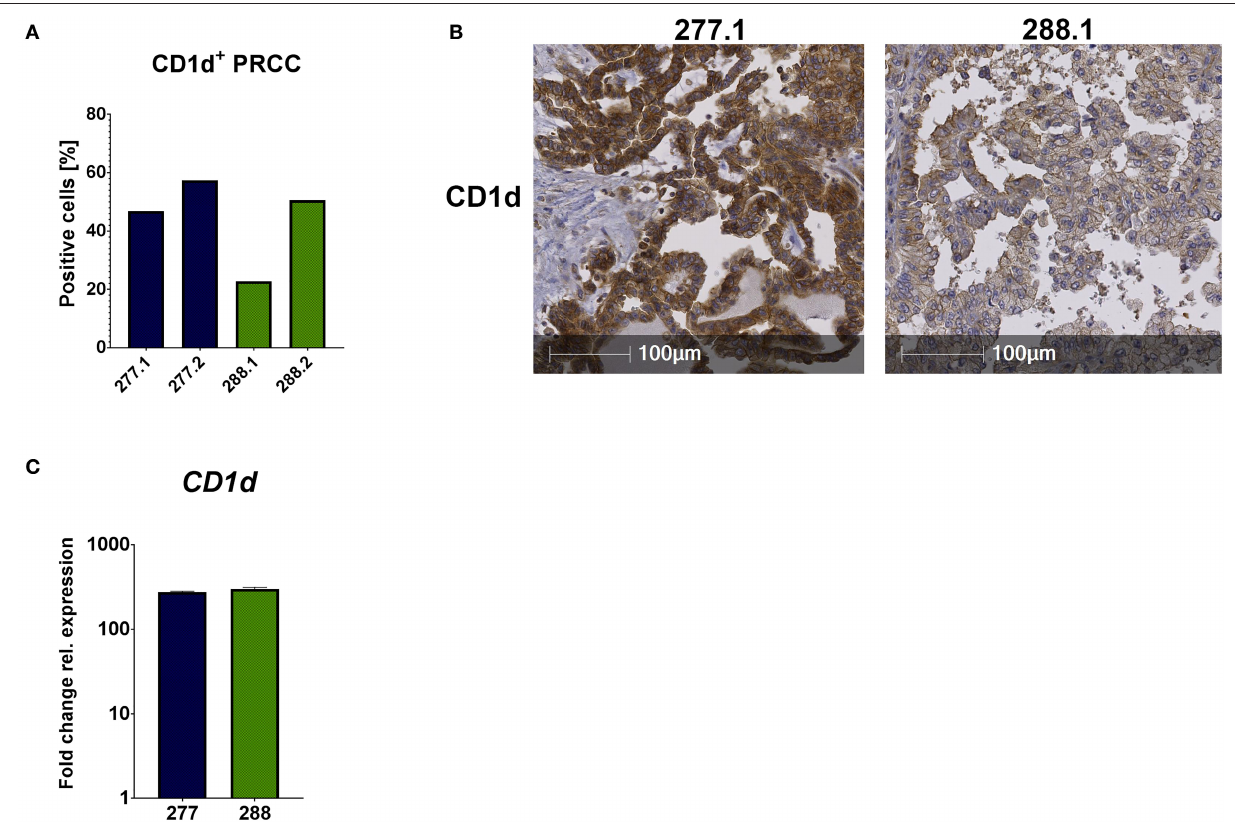
FIGURE 4 | CD1d is expressed by PRCC. PRCC samples were analyzed for their CD1d expression using IHC staining and qRT-PCR. (A) Quantification of CD1d + tumor cells of sample 277 and 288, showing high expressions of CD1d protein. Of each case two different sections were stained and analyzed (277.1, 277.2, 288.1 and 288.2). After defining the tumor area, quantification of CD1d + tumor cells was performed with HALO software. (B) Representative immunohistochemical anti-CD1d staining of sample 277.1 and 288.1. Sample 277.1 shows a stronger CD1d expression than sample 288.1. (C) qRT-PCR expression analysis of CD1d mRNA was performed. After normalization to the housekeeping gene HPRT, fold change quantification was performed with respect to pediatric normal kidney tissue (sample 91). Analysis was performed in